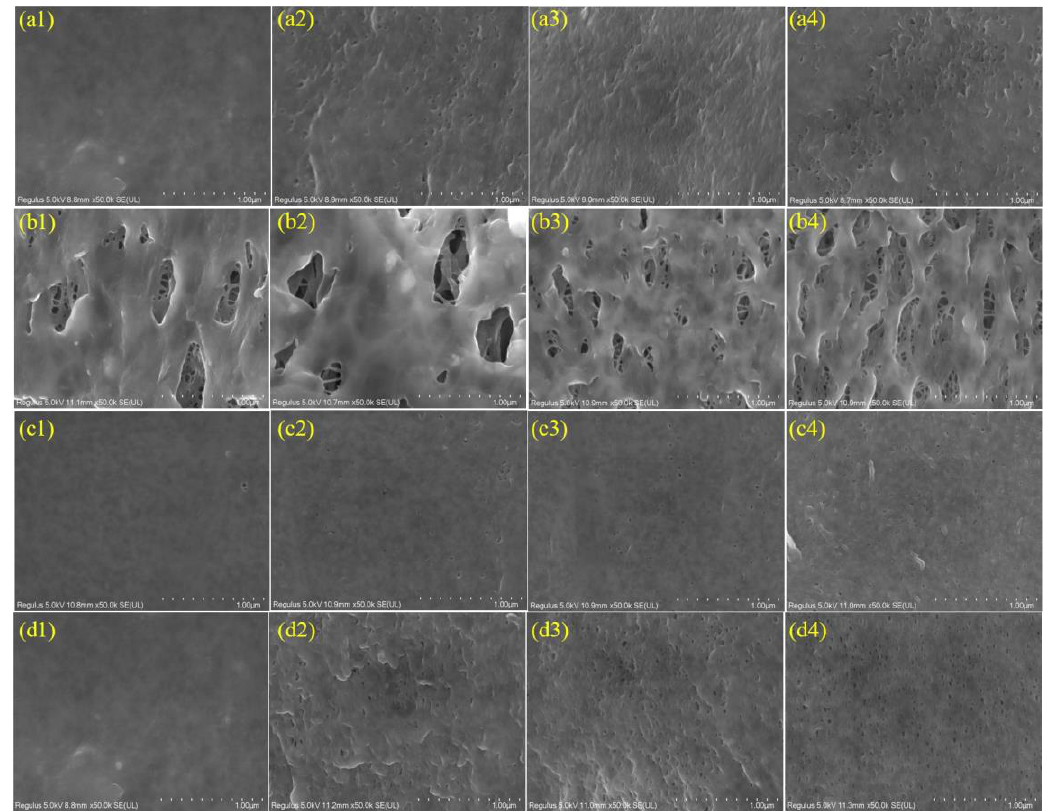
Figure 1. FESEM images of the outer surface morphologies of the pristine and NaOCl-exposed membranes. ( a ) A membrane, NaOCl Ph = 10; ( b ) B membrane, NaOCl pH = 10; ( c ) C membrane, NaOCl pH = 10; and ( d ) A membrane, NaOCl pH = 8; 1, 2, 3, and 4 represent exposure time 0, 48, 192, and 500 h, respectively.